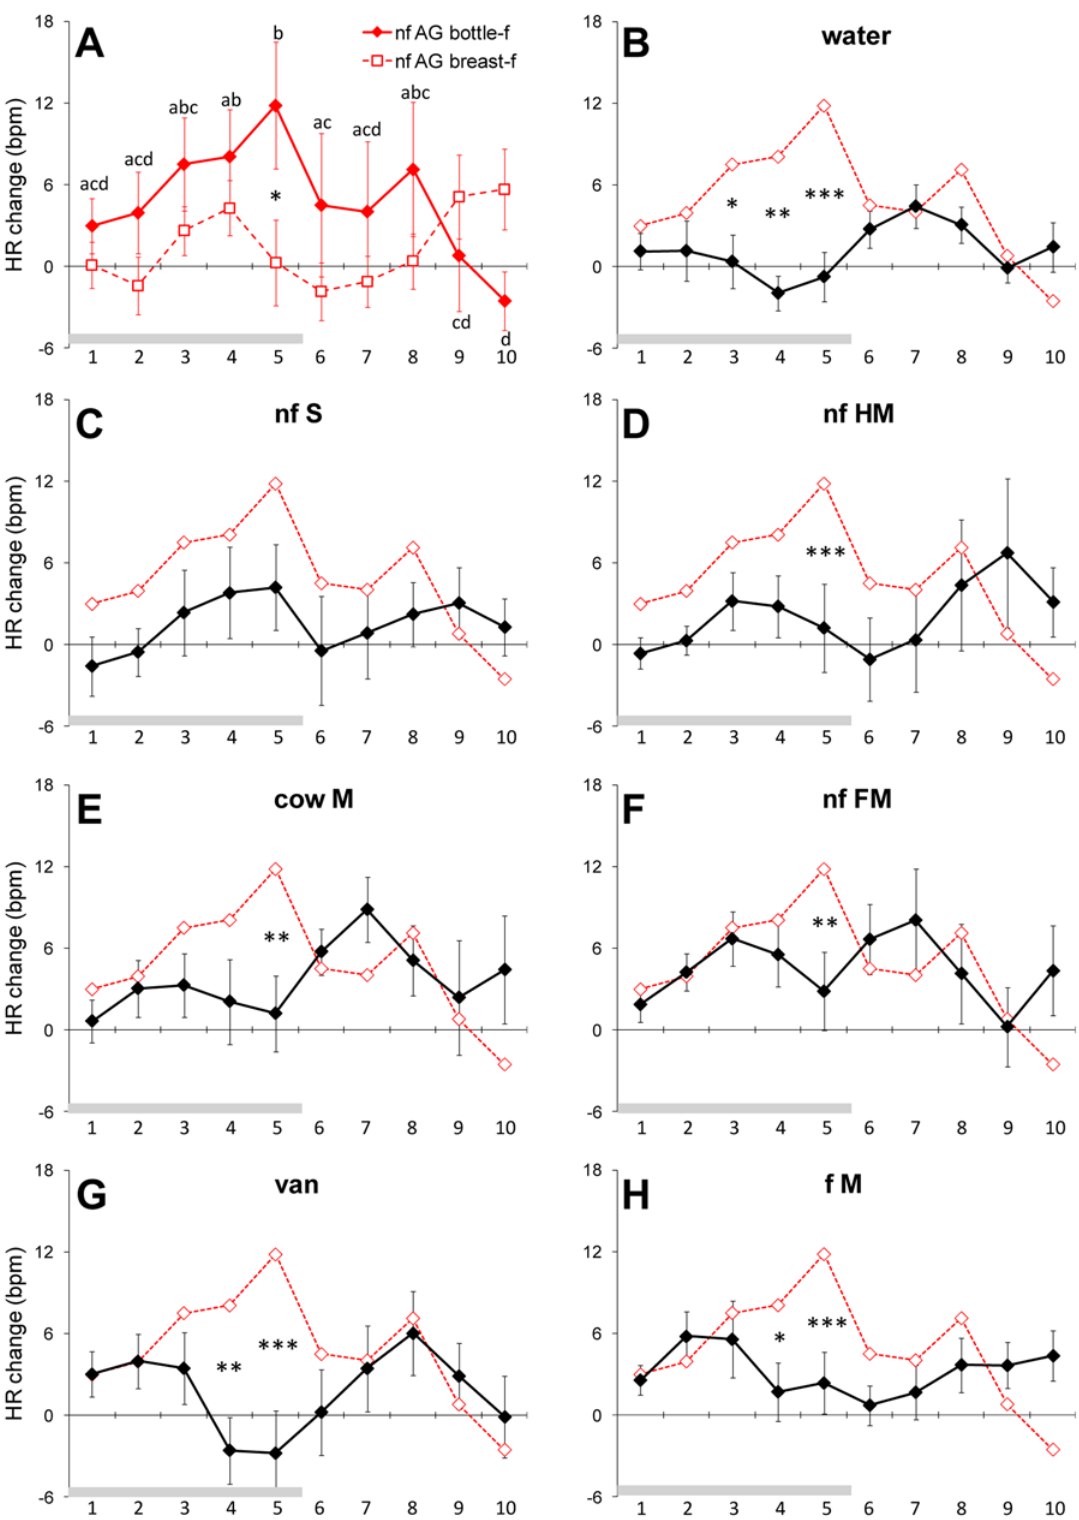
Figure 4. Cardiac response to the areolar odor and the reference stimuli. A) Mean ( 6 sem) heart rate (HR) change of bottle- and breast-fed newborns inresponse toareolar secretions (n=8and8; values ofHRchange ofbottle-fednewbornsinresponsetoAGodor thatdiffer significantlyfromthe baseline are indicated by different letters); B to H) Mean ( 6 sem) HR change of bottle-fed newborns during (blocks 1–5) and after (blocks 6–10) exposure to water (B), sebum (C), human milk (D), cow milk (E), formula milk (F), vanillin (G); and the infant’s familiar milk (H) (Key to abbreviations, cf. Figure 1). Comparisons between the different stimuli (bold curves) and AG odor (red curves) are indicated by *, ** and ***: p , .05, .01 and .005, respectively; n=8).